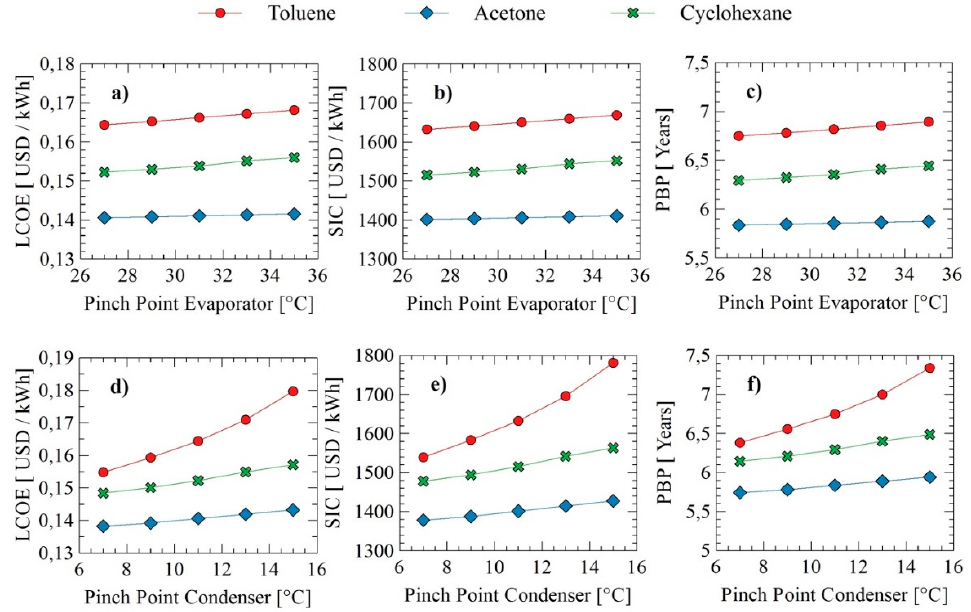
Figure 8. Effect of condenser and evaporator pinch point on ( a , d ) LCOE, ( b , e ) SIC, and ( c , f ) PBP using toluene, acetone, and cyclohexane as working fluid.